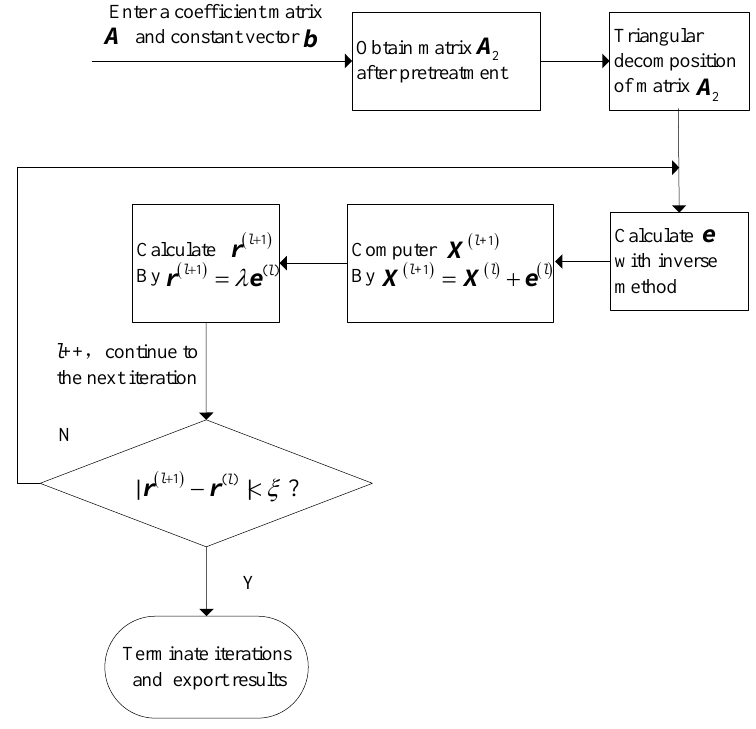
Figure 4. Flows of adaptive iteration for Hammerstein kernel vector.